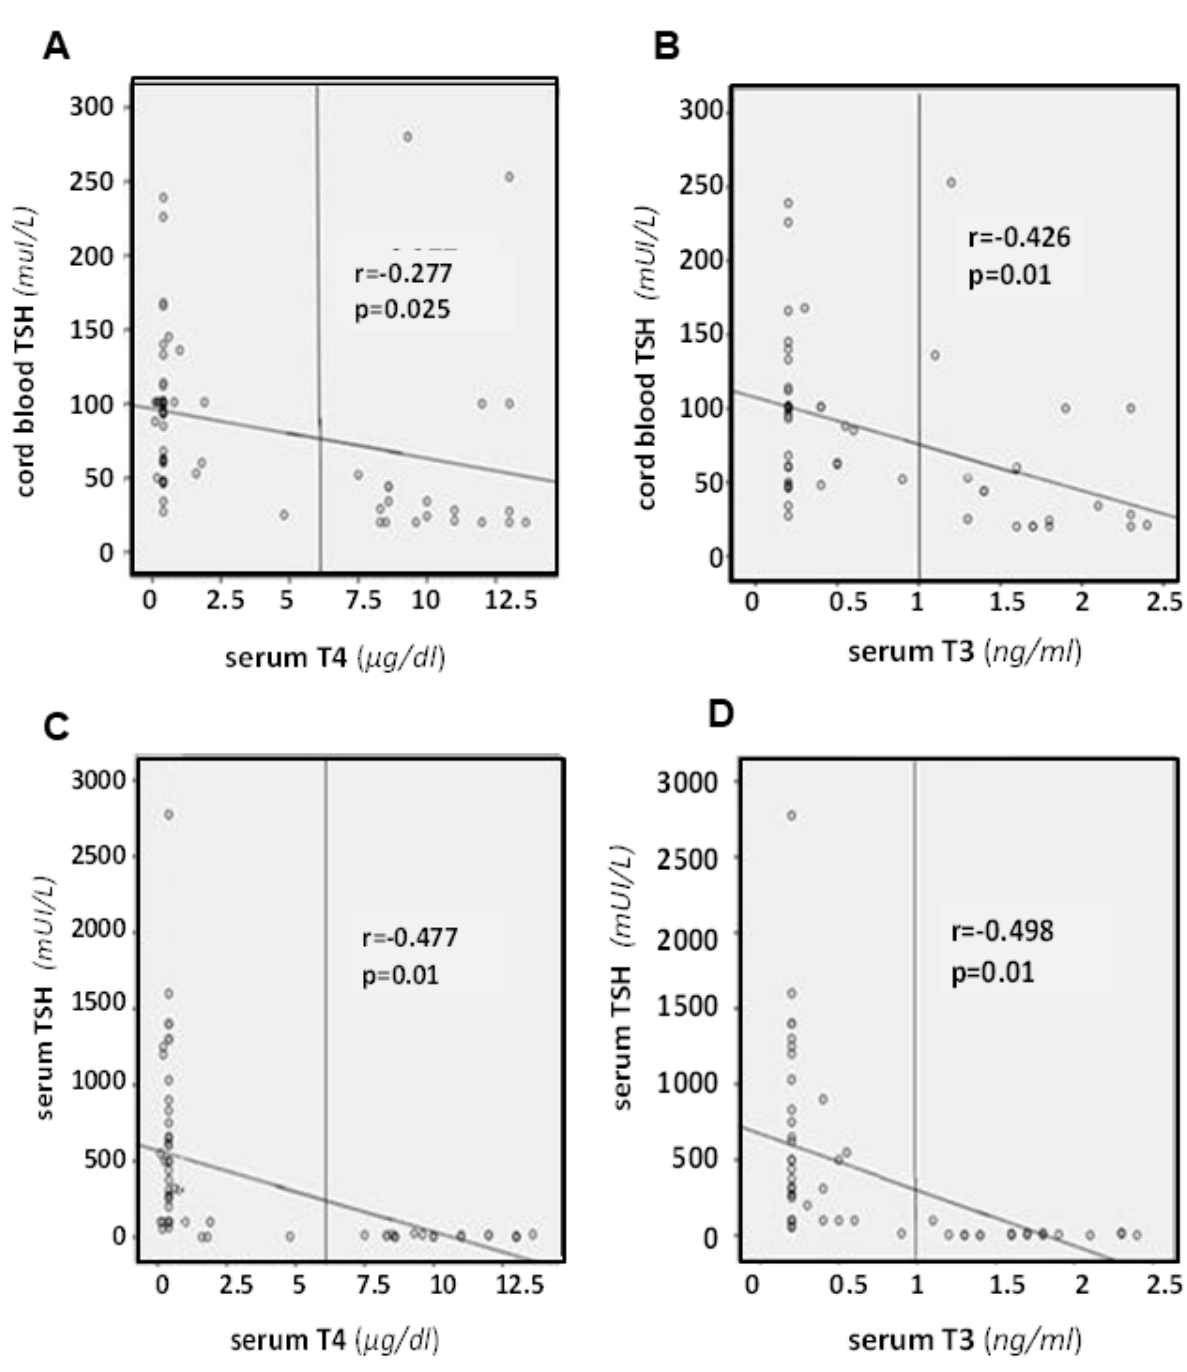
Figure 4. Correlations between cord blood TSH at CH screening, or serum TSH at CH confirmation and thyroid hormones, T4 or T3 at CH confirmation. A . Correlation between cord blood TSH and serum T4 (p= 0.025, r= -0.277) B. Correlation between cord blood TSH and serum T3 (p= 0.01, r= -0.426). C. Correlation between serum TSH and T4 (p= 0.01, r= -0.477). D . Correlation between serum TSH and T3 (p= 0.01, r=